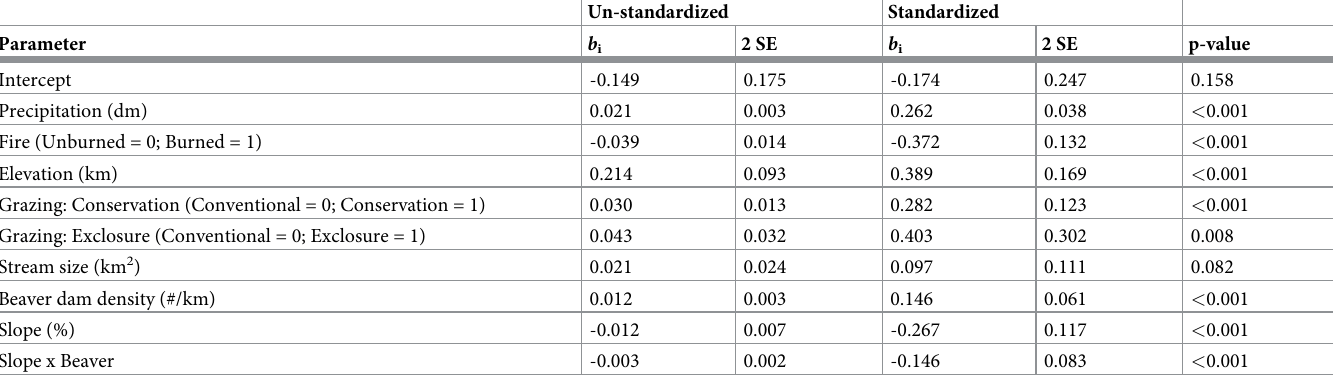
Table 4. Parameter estimates and p-values from a multiple regression model predicting